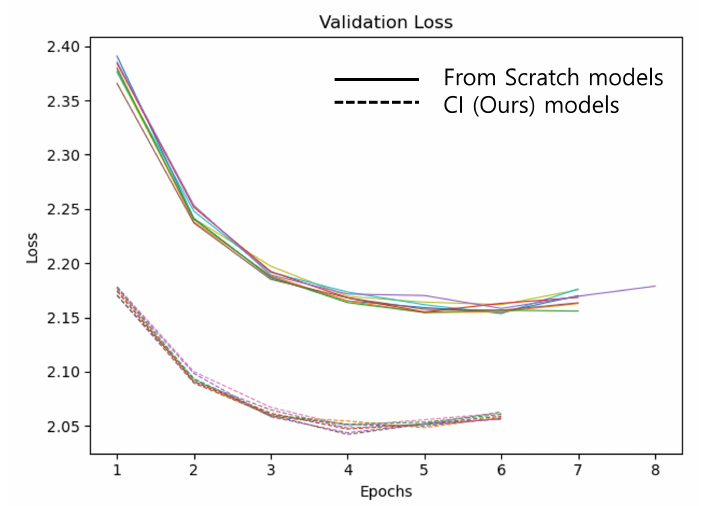
Figure 8. Vanilla image captioning model validation loss. The solid line are the From Scratch models and the dotted line are the CI models (ours). Each model was trained 8 times and is marked with different